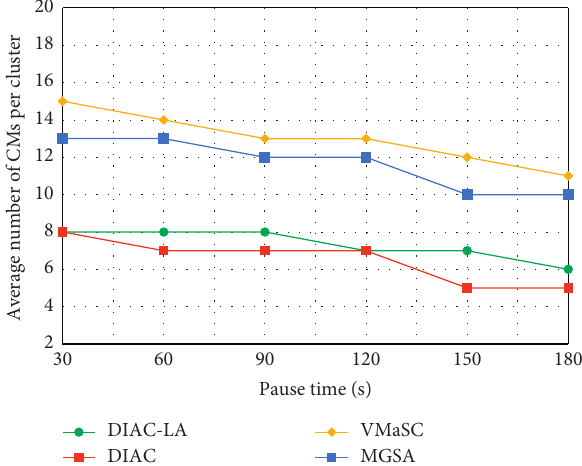
Figure 6: Number of CMs per cluster at different pause times of